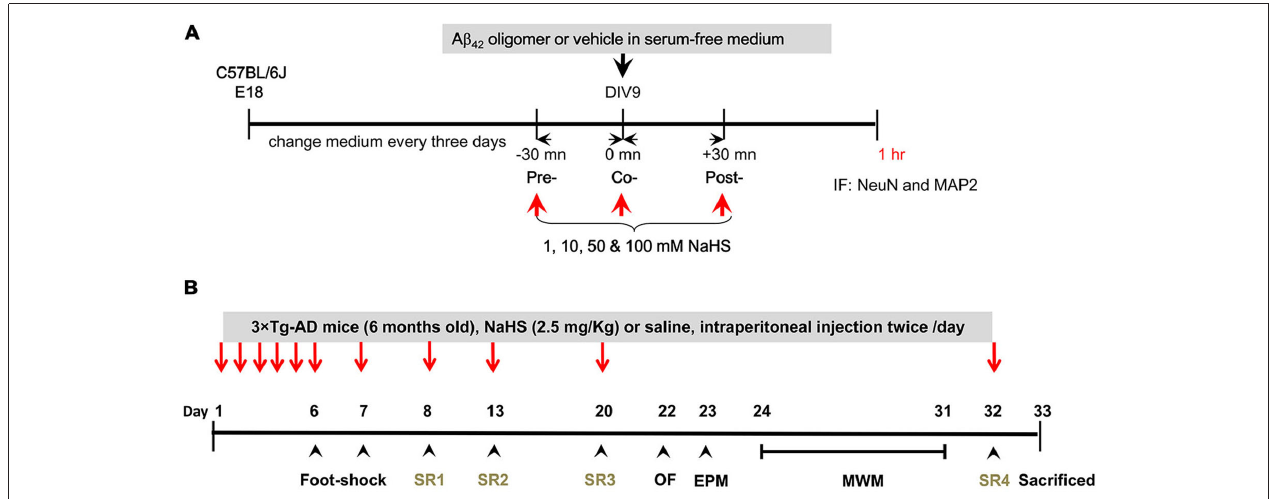
FIGURE 1 | Schematic diagram of this study. (A) The experimental timeline for the in vitro experiment. Embryonic (E 16–18) hippocampi were isolated for primary culture. At DIV 9, different doses of NaHS (1, 10, 50 or 100 µ M) were applied to the hippocampal primary cultures 30 min before (pre-treatment), after (post-treatment), or simultaneously with (co-treatment) the application of oligomeric A β 42 . Cells were harvested for IF staining with NeuN and MAP2 antibodies after treatment with oligomeric A β 42 for 1 h. (B) The experimental timeline for the in vivo treatments and assays. NaHS (arrows) was applied over the first 5 days and each foot shock and SR (arrowheads) on days 8, 13, 20, 32. OF and EPM tests were conducted to measure anxiety levels. The MWM was conducted on days 24–31 to assess the spatial learning and memory of the mice. After SR4, all mice were sacrificed for pathological analyses on day